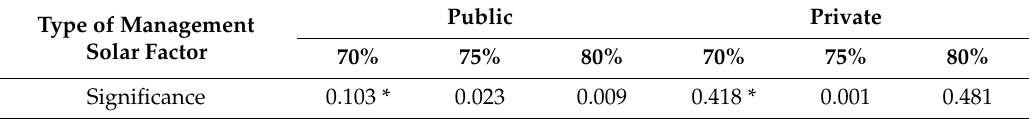
Table 7. Shapiro–Wilk’s test results for data categorized by type of management.